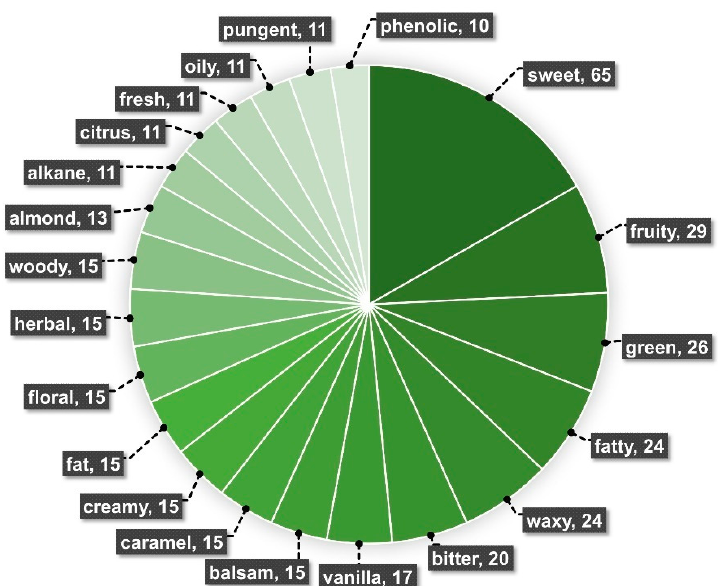
Figure 6. Pool of the most frequent flavor descriptors, retrieved from the Flavor DB, associated with molecules identified in the fruits of vanilla crop WR and hybrid species. The numbers represent the count in which each descriptor is reported. Table 3. Molecules commonly associated with the commercial natural vanilla flavor identified in the fruits of vanilla crop WR species. Numbers refer to respective